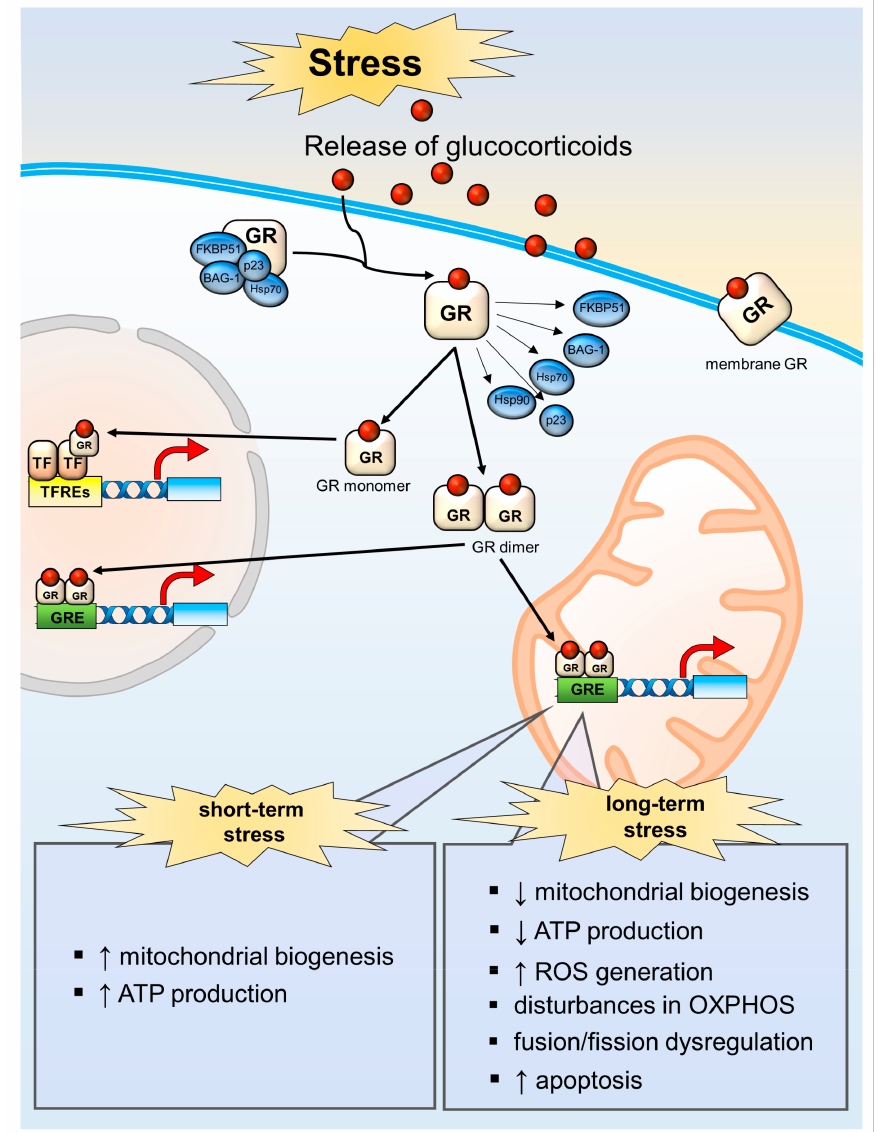
Figure 2. A schematic diagram illustrating the effects of short-term and long-term effects of glucocor- ticoids on mitochondrial function. GR—glucocorticoid receptor; GRE—glucocorticoid responsive element; TF—transcription factors; TREs—transcription factor responsive elements; FKBP51, BAG-1, Hsp-90, Hsp-70, p23—glucocorticoid receptor co-chaperones: FKBP51—FK506 binding protein